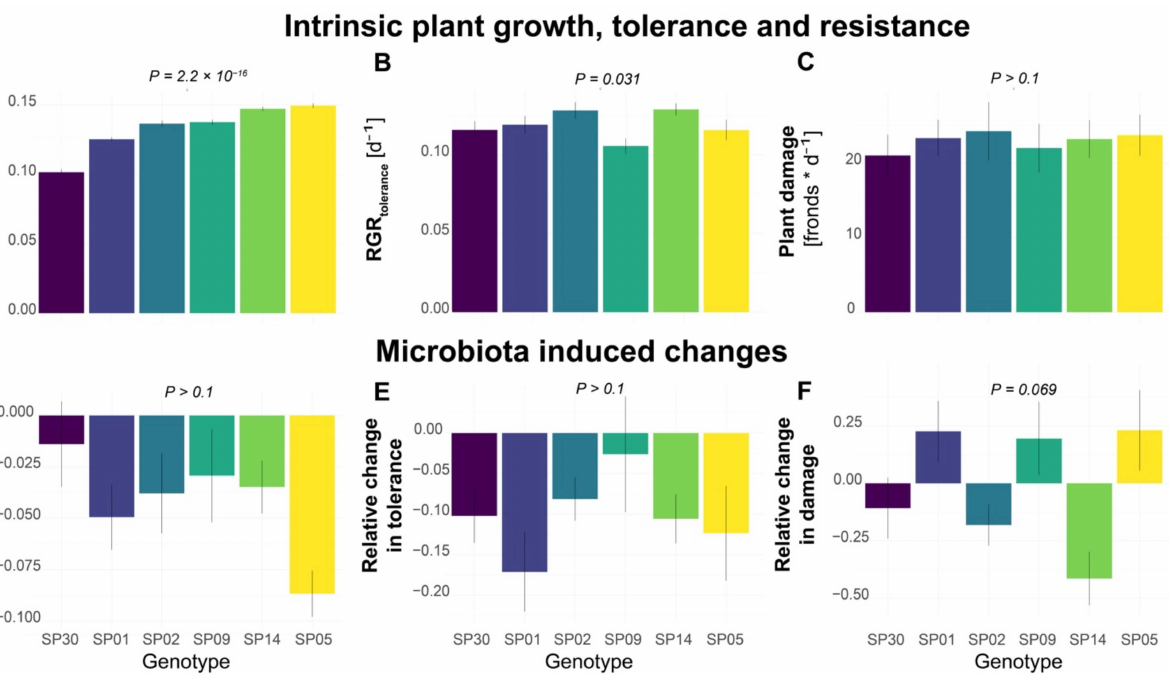
RGR (Figure 1A, genotype effects: p = 2.2 × 10 − 16 , Kruskal–Wallis rank sum test). While genotype SP05 showed the highest growth rate, genotype SP30 had the lowest growth rate.